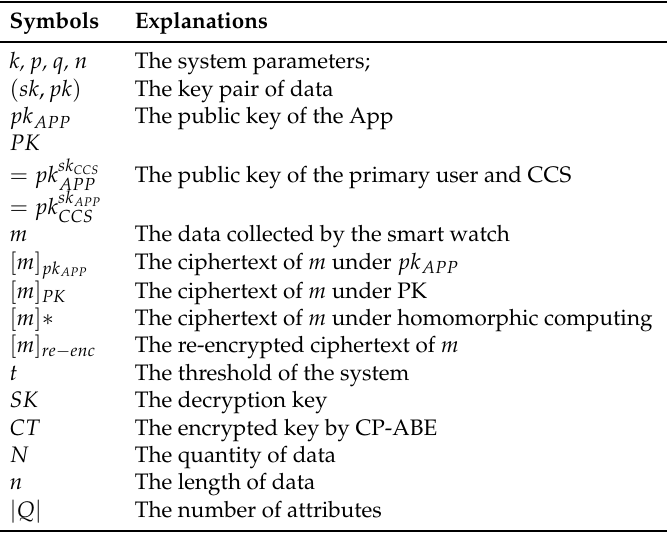
Table 1. Symbols and their